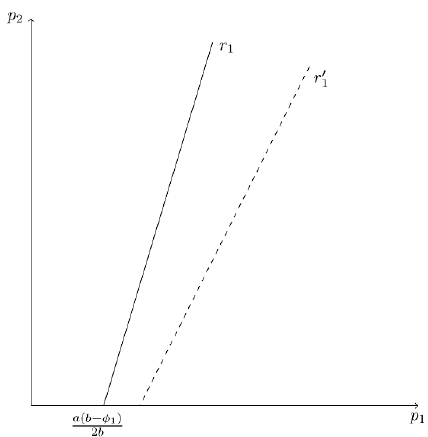
Figure 6. Firm 1 ʹ s Best ‐ Reply Curve in the Bertrand Model When CEO 1 Underestimates Product Substitutability.